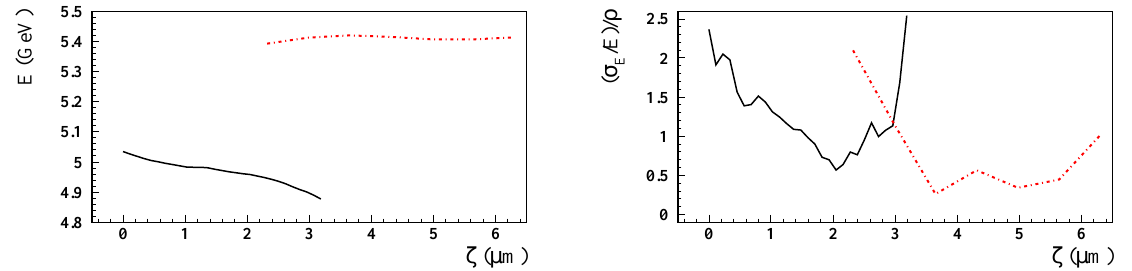
Figure 8. Comparison between Maynard–5 (solid black line) and Rossi–5 (dot-dashed red line) beam distributions in the energy ( left ) and ( σ E / E ) / ρ ratio ( right ) longitudinal